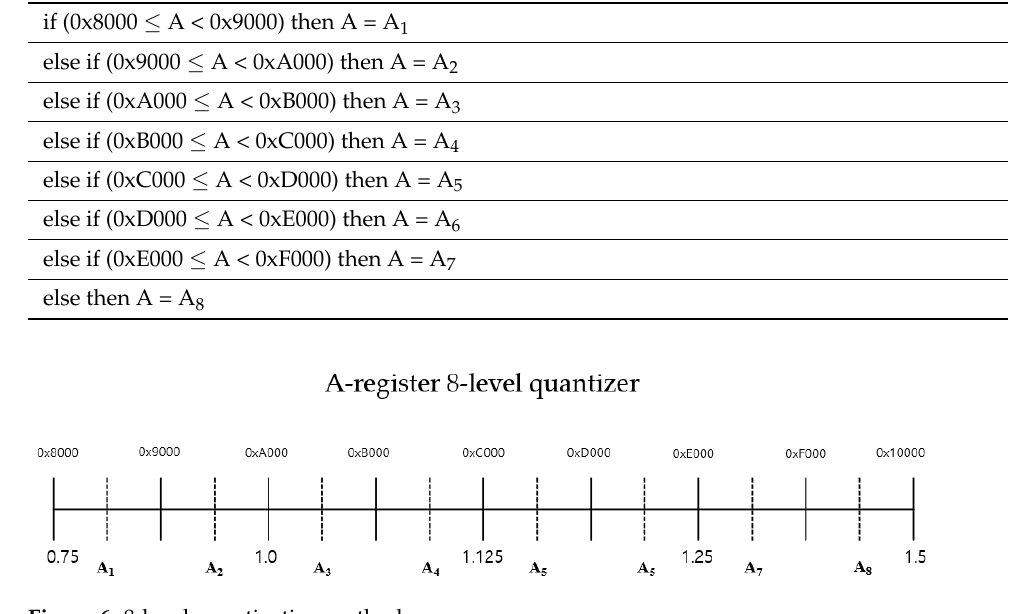
Figure 6. 8-level quantization method. Table 9. Two-modes of 8-level quantization.